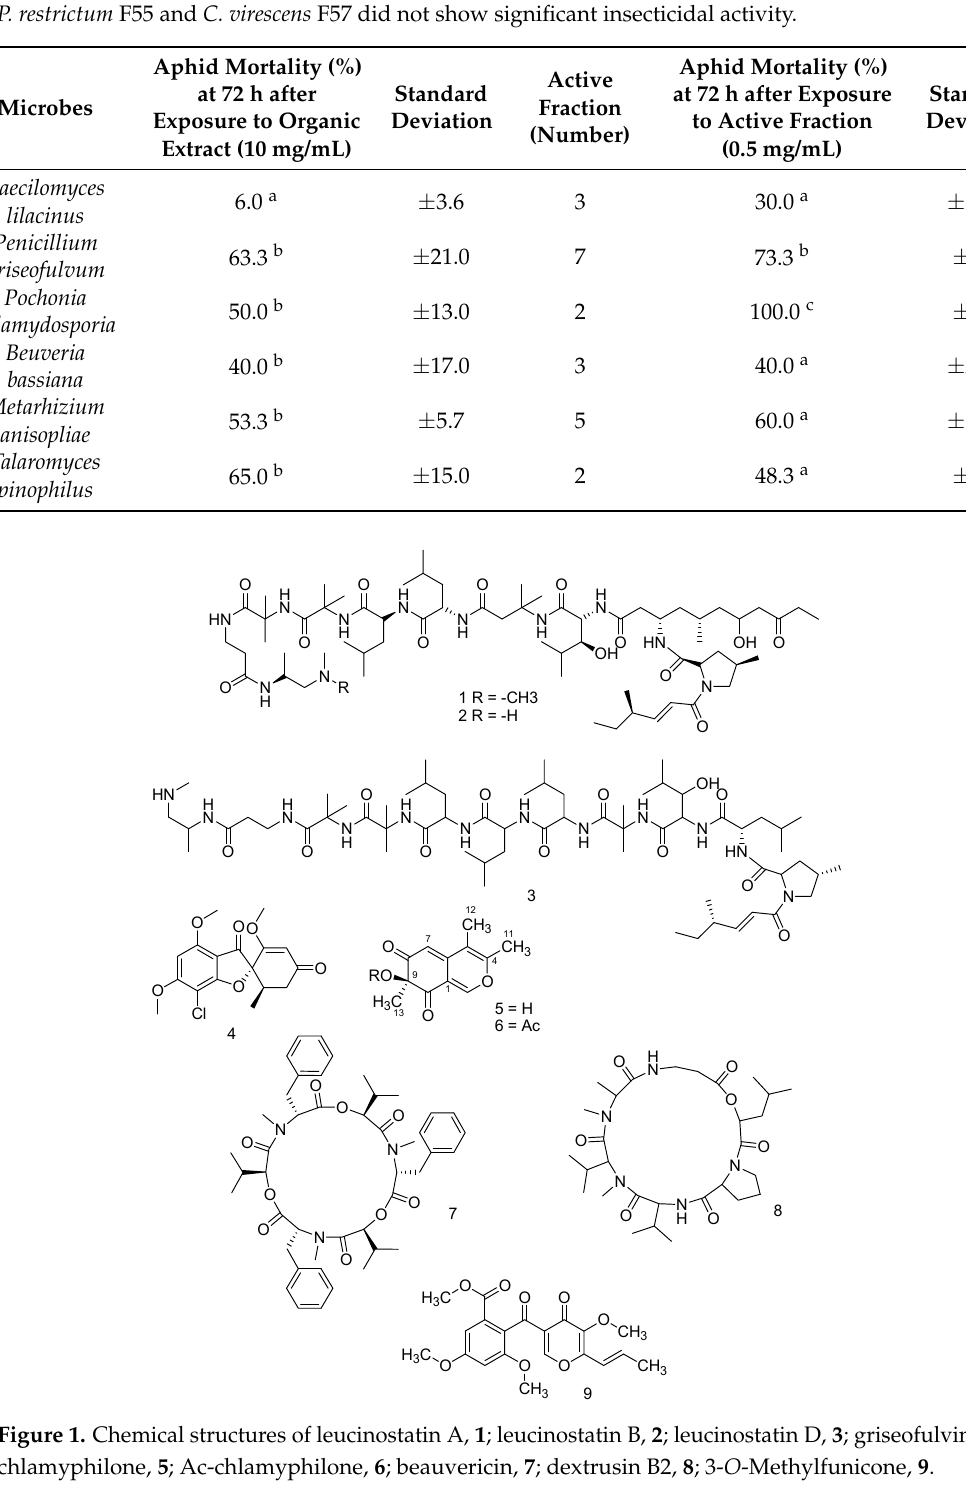
Table 1. Insecticidal activity of fungal organic extracts and active fractions as mortality (%) of the pea aphid Acyrthosiphon pisum at 72 h after exposure. Different lower letters refer to significant differences ( p < 0.05) among treatments at the same incubation time. Extracts from T. tomentosum F19, T. asperellum